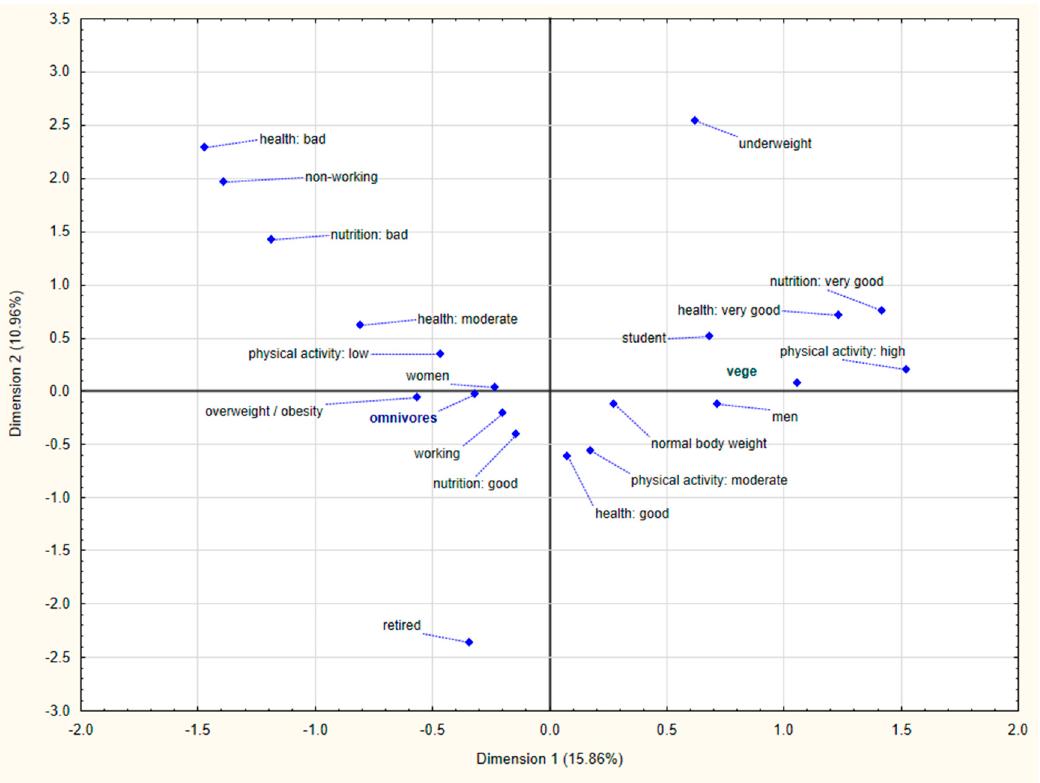
Figure 1. Characteristics of adult omnivores and vegans according to the parameters concerning gender, body mass, health status, physical activity and self-reported diet quality (the correspondence analysis).